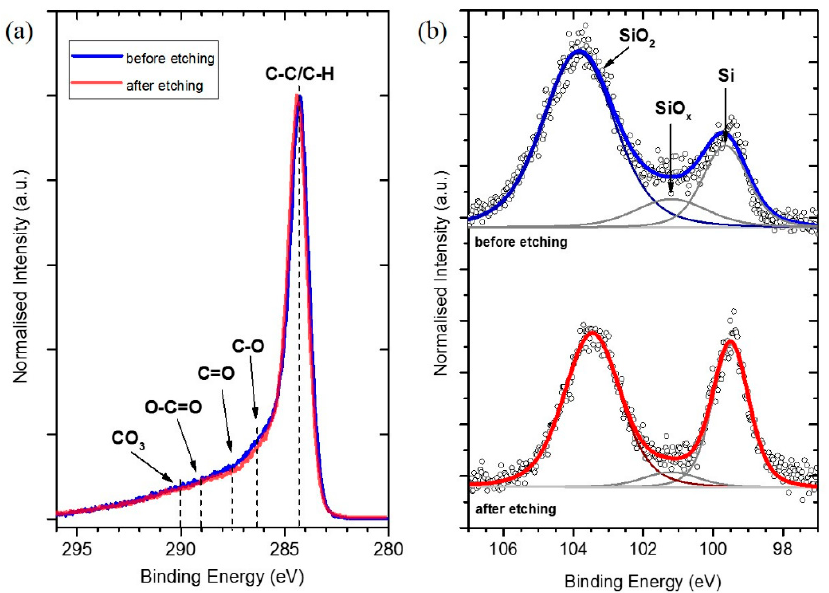
Figure 4. Normalised ( a ) C 1s and ( b ) Si 2p XPS detail spectra of Si/MC before and after HF etching. Dashed lines indicate the positions of different C/O components. SiO 2 signals are shown in dark blue/red, all others in dark grey.